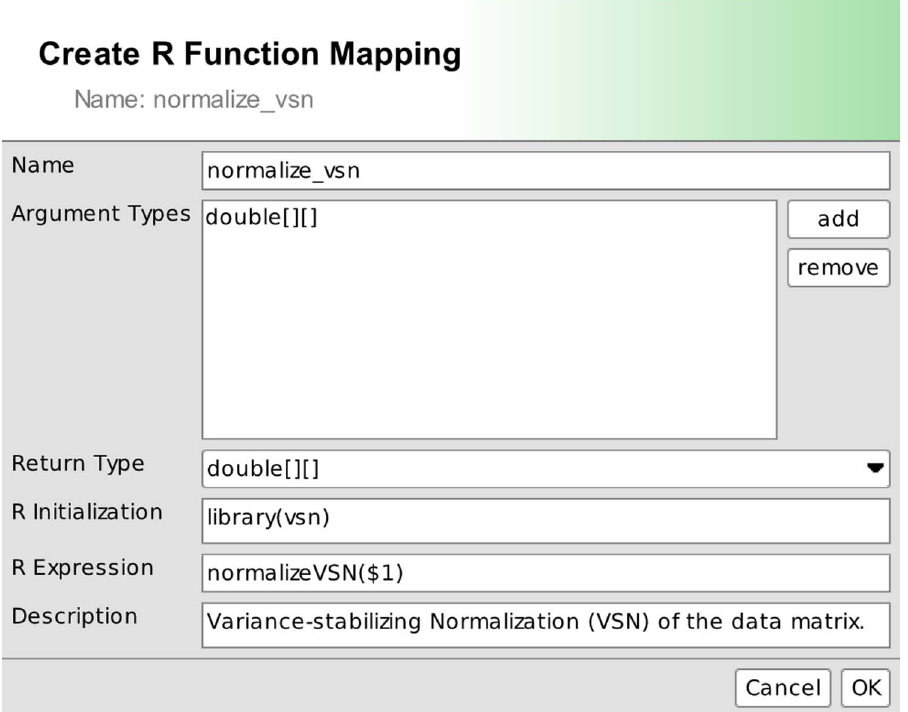
Figure 4. Access R from BiNA. The editor for connecting R expressions with functions in BiNA. The new normalize_vsn(x) function calls the underlying R statement normalizeVSN(x).